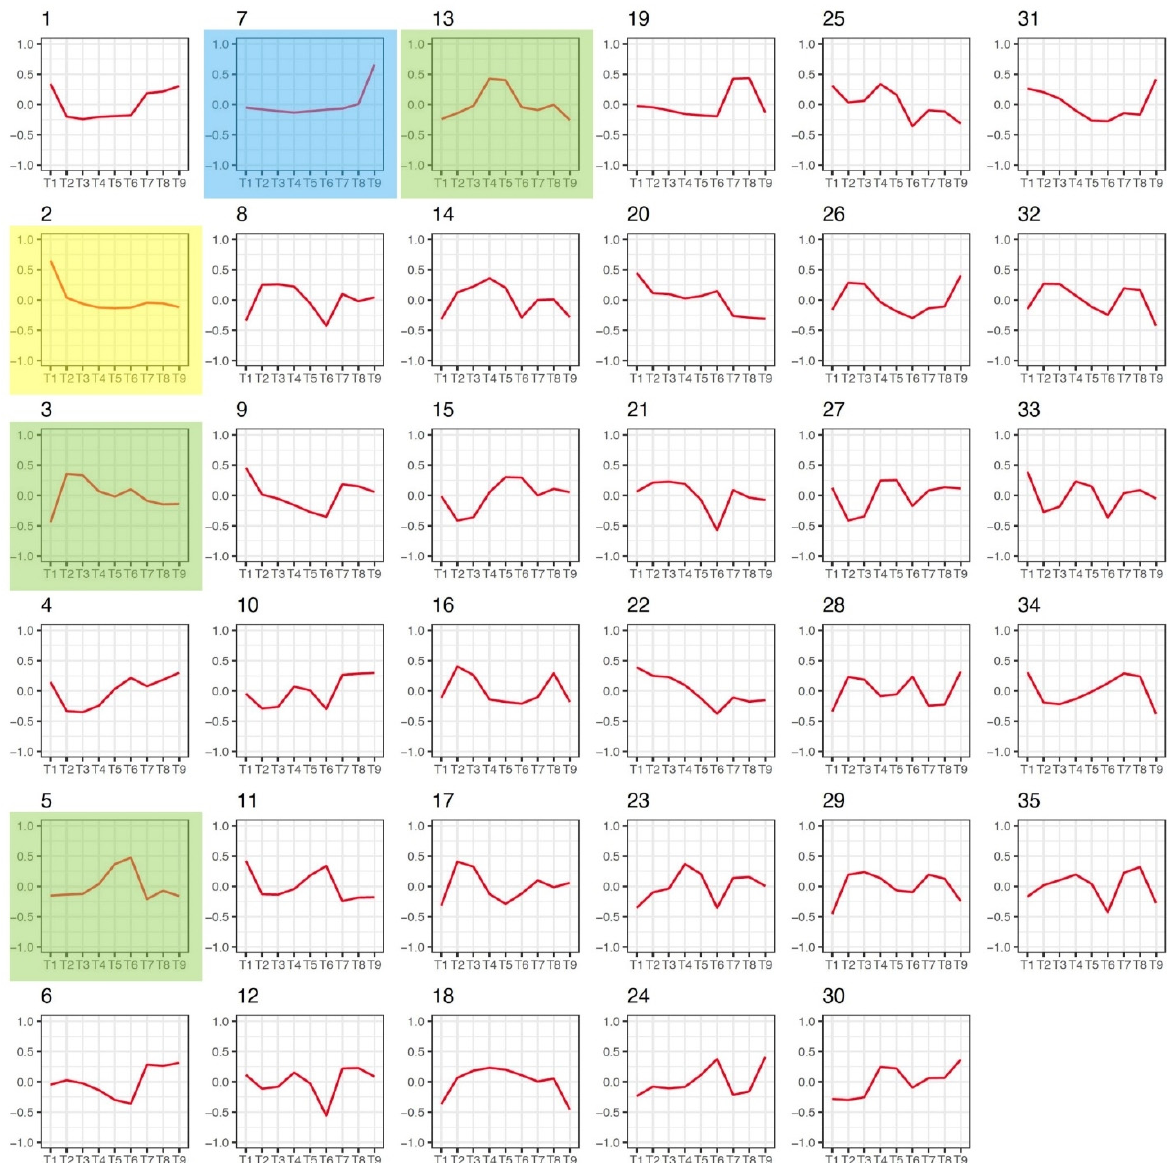
Figure 2. The 36 co-expressed gene modules identified through WGCNA. Module eigengene (ME) values were calculated for each tissue/stage. Line plots were generated based on ME values for all 36 modules. X -axis, nine tissues and stages. T1, anther; T2, GE; T3, HE; T4, TE; T5, CE; T6, ME; T7, ovary; T8, seed; T9, root. Y -axis, ME values. Five modules containing anther-specific (ME2), root-specific (ME7), and embryo-specific genes (ME3, 5, 13) were colored with yellow, blue, and green backgrounds, respectively.